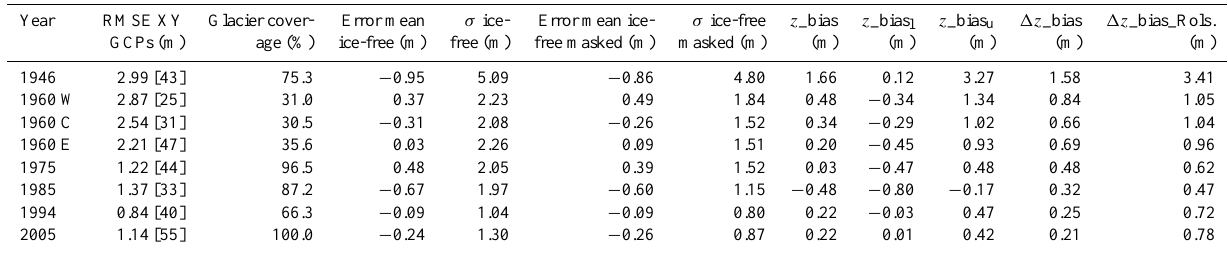
Table 2. The horizontal RMSE of the GCPs (no. of GCPs within brackets), glacier coverage and error assessment of the photogrammetric DEMs, using four different approaches: (i) direct comparisons of ice-free areas (mean and standard deviation ( σ )); (ii) comparisons in ice-free areas after masking out outliers and areas with slope>20 ◦ (see Sect. 2.2); (iii) SGSim, in which z _bias corresponds to the mean elevation bias from 1000 simulation, z _bias u and z _bias l to the upper and lower 95% confidence level and (cid:49)z _bias = ( z _bias u − z _bias l )/ 2; (iv) method described by Rolstad et al. (2009). To derive uncertainties with 95% confidence level we assume normal probability function and therefore (cid:49)z _bias Rols = 1 . 96 × σ z _bias_Rols